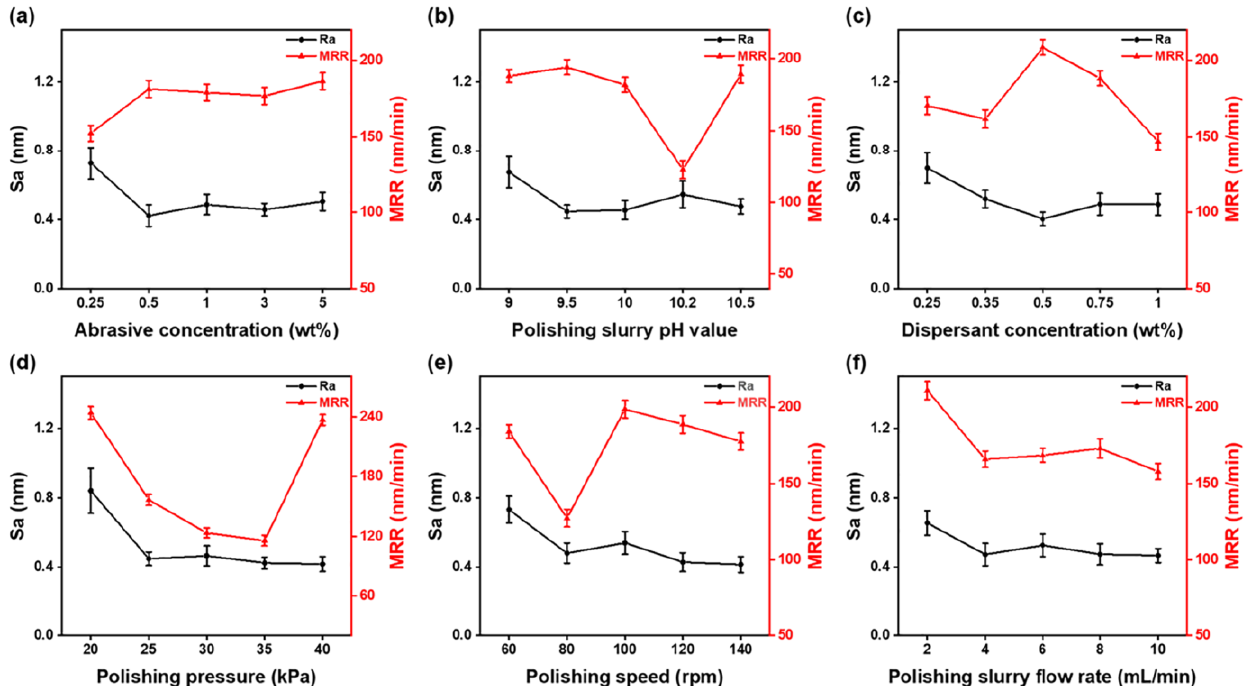
Figure 4. Effect of ( a ) abrasive concentration, ( b ) pH, ( c ) dispersant concentration, ( d ) polishing pressure, ( e ) polishing speed, and ( f ) polishing slurry flow rate on Sa and MRR in orthogonal ex- periments.